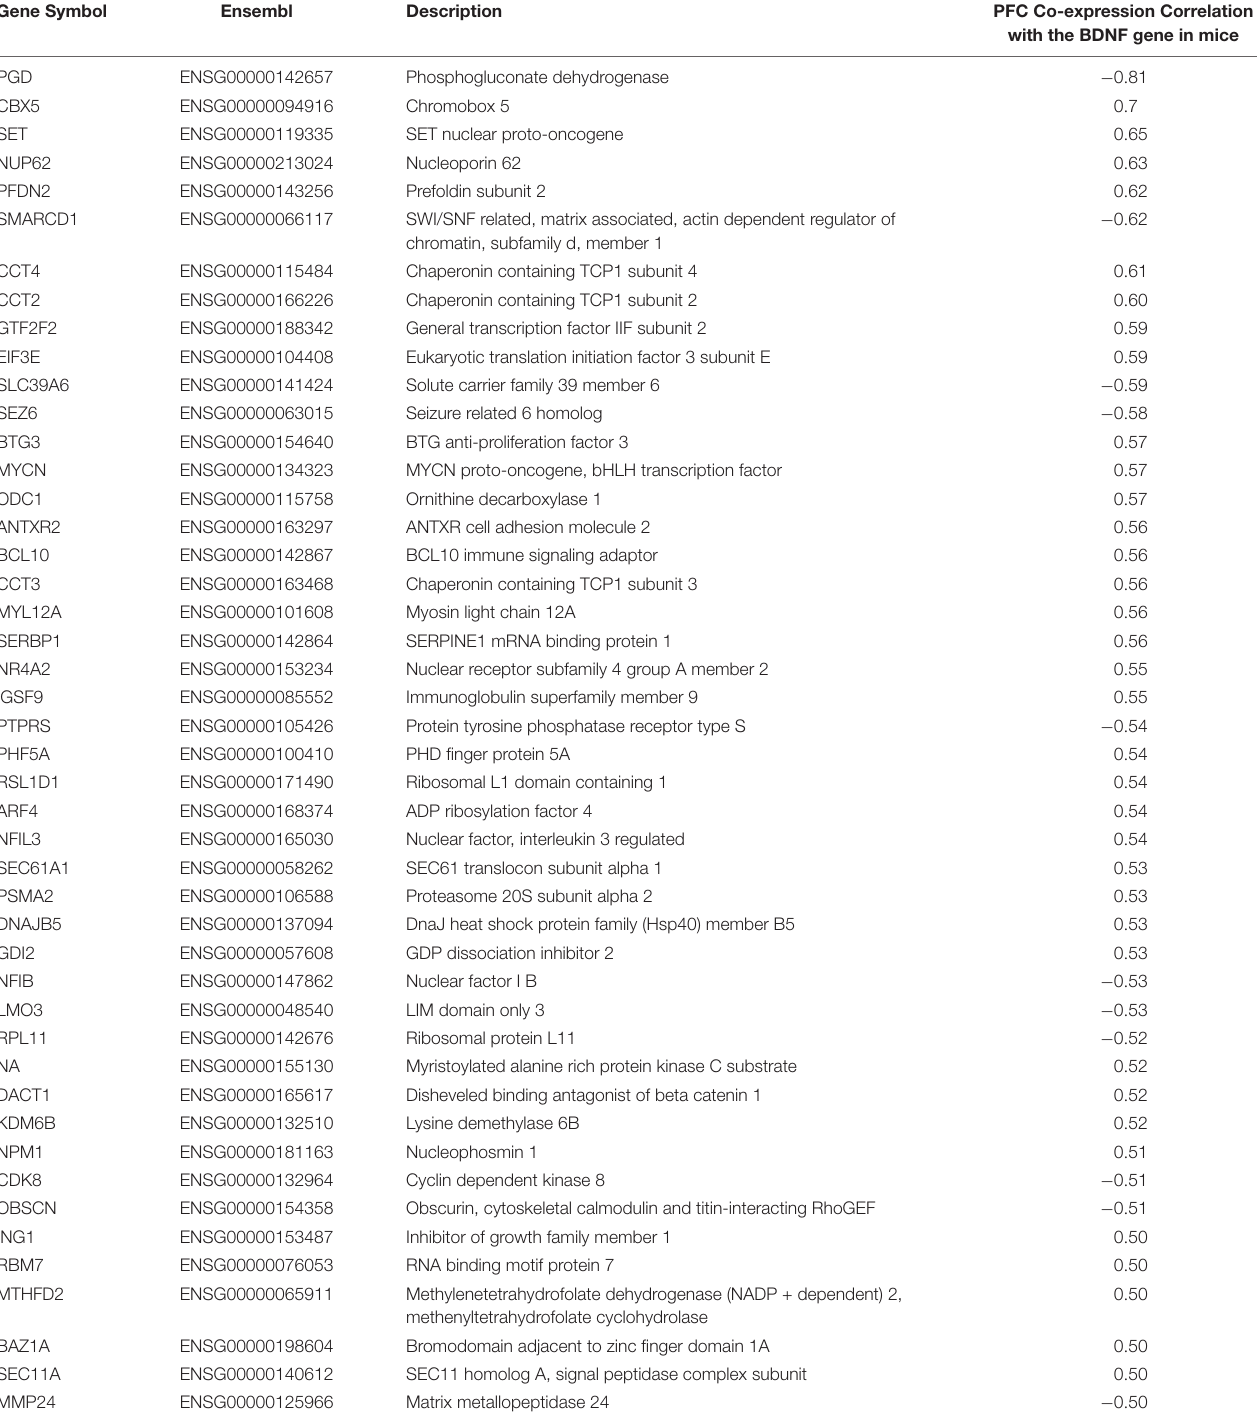
TABLE 3 | List of genes co-expressed with the BDNF gene and included in the PFC BDNF ePRS. Gene Symbol Ensembl Description PFC Co-expression Correlation